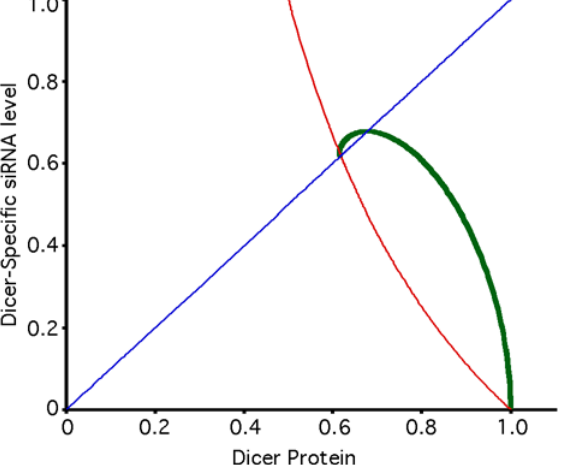
Figure 2. Phase plane diagram of recursive RNAi of Dicer. Phase plane diagram of Dicer RNAi showing the nullclines for which the rate of change of either the siRNA (in blue) or Dicer protein (in red) equals zero. The two curves only intersect for one set of values, indicating a unique steady-state solution. The transient solution starting from an initial condition of normal dicer level and zero Dicer-directed siRNA is plotted in green, obtained by numerical integration. This simulation was conducted with an RNAi efficacy parameter gamma equal to 1.